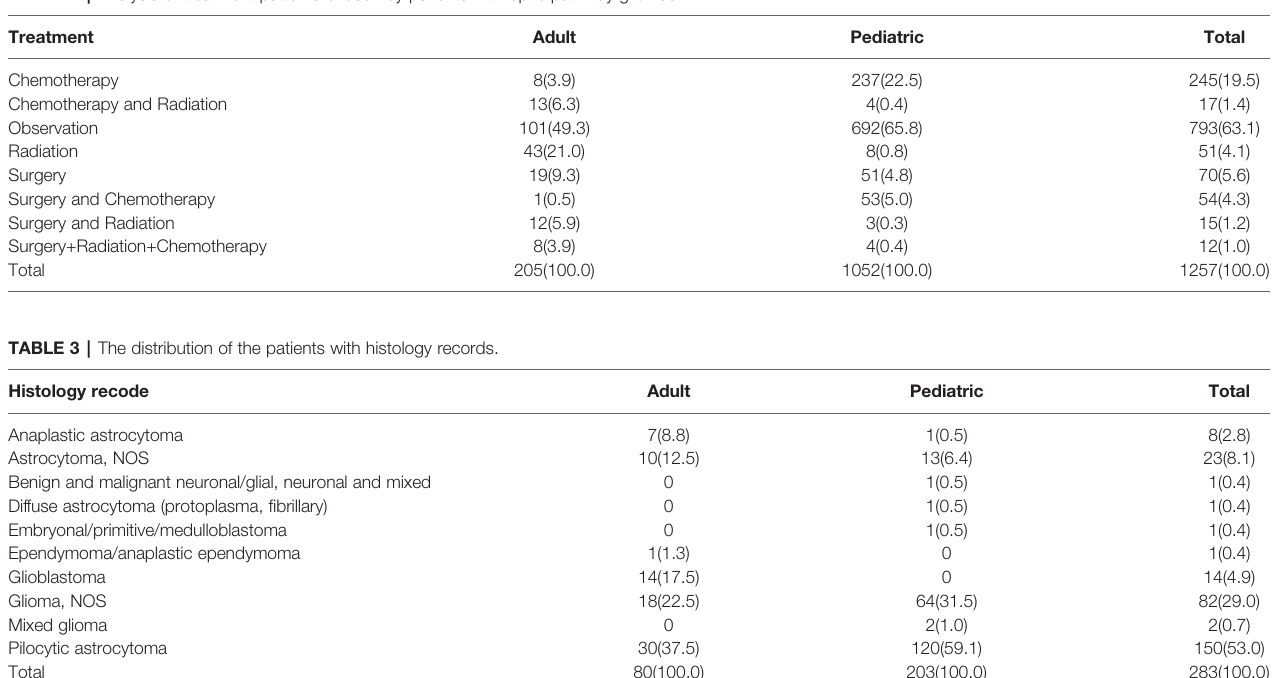
TABLE 2 | Analysis of treatment patterns chosen by patients with optic pathway gliomas.